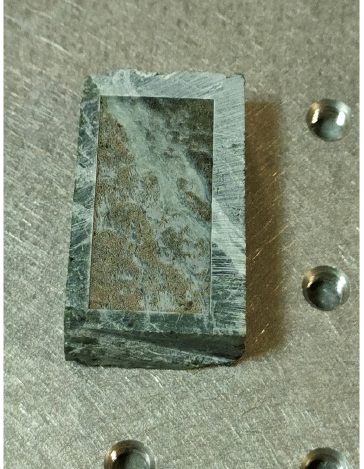
Figure 5. Rock sample after laser ablation.